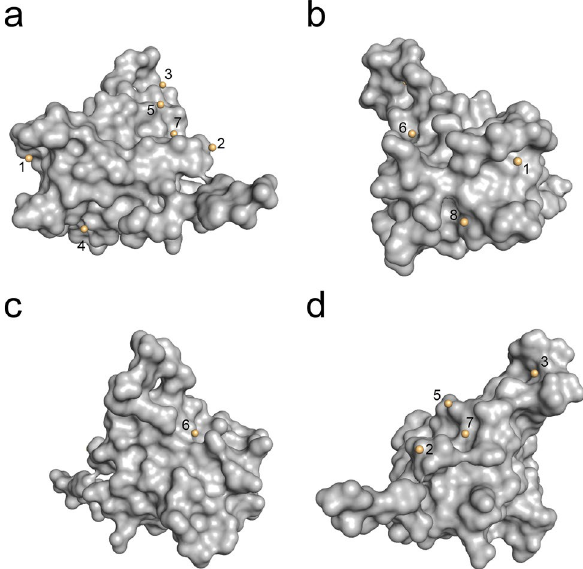
Figure 7. Overview of all observed cesium sites in the p62 PH domain. Numbering is coherent with Table 10. P62 PH is represented as grey surface, cesium ions as yellow spheres. ( a ) Front view. ( b ) Side view left. ( c ) Back view. ( d ) Side view right.